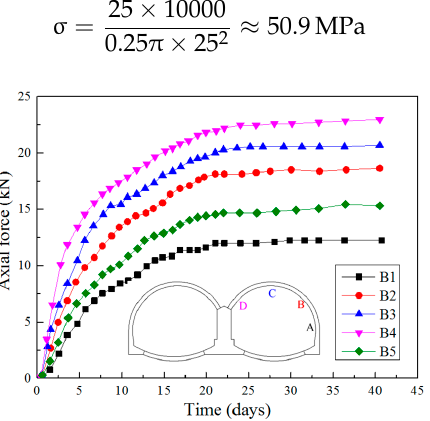
Figure 16. Time history plots of the axial forces in rock bolts at location B in the K89+729 section.